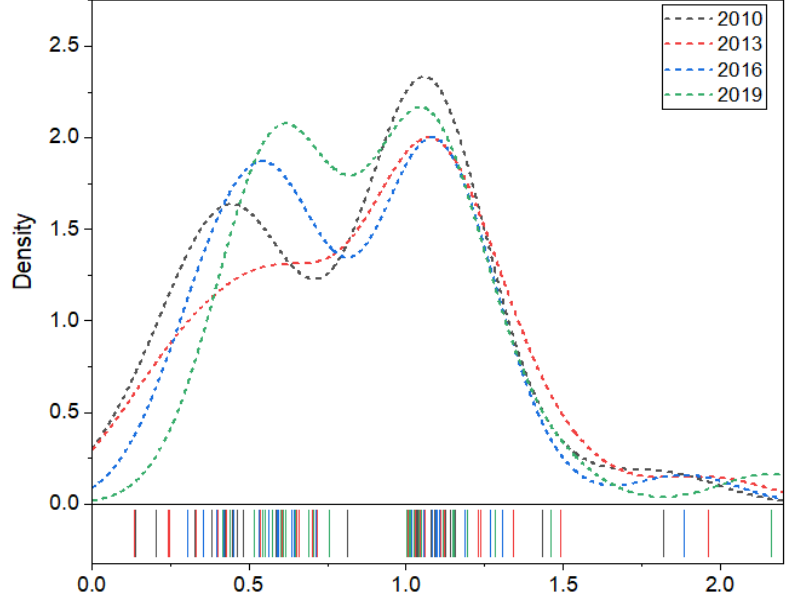
Figure 3. Kernel density distribution of green innovation efficiency in China.